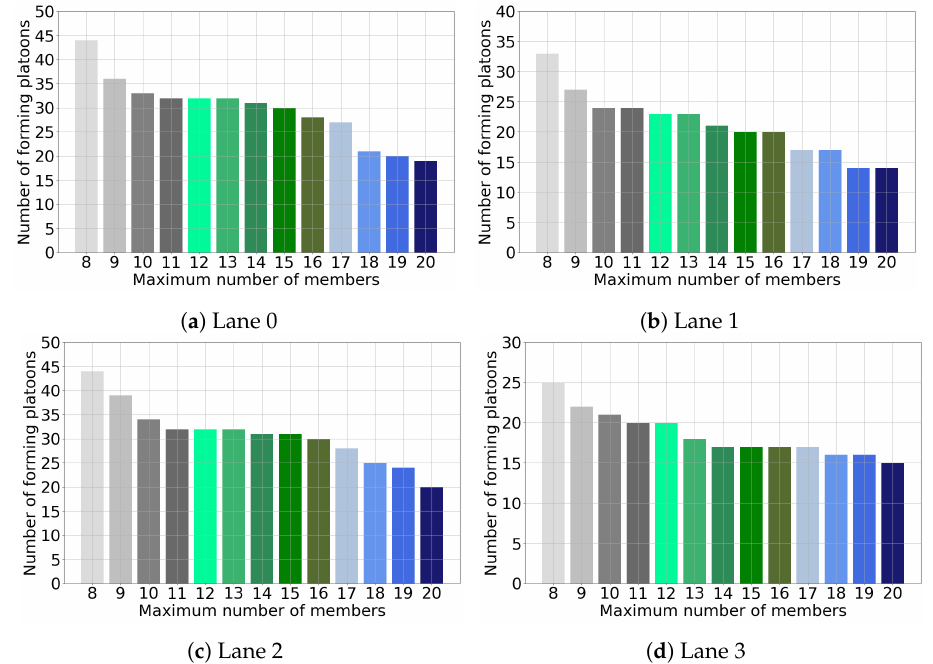
Figure 4. The number of forming platoons in Lane 0 to Lane 3 in three scenarios of